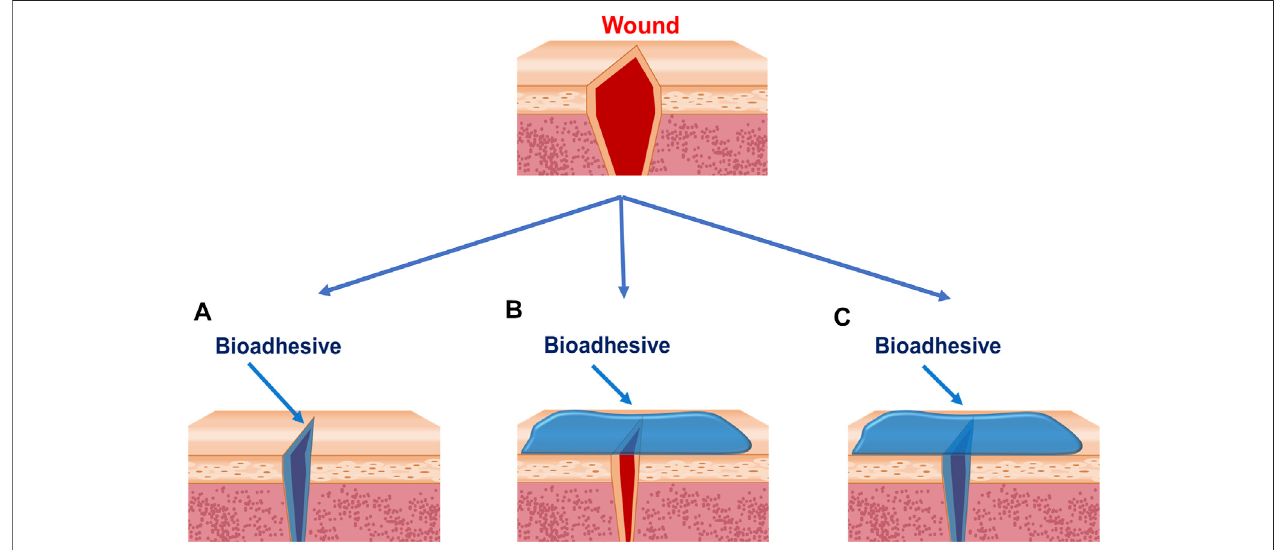
FIGURE 2 | Strategies bioadhesives used to close wounds. (A) Bioadhesives are applied between wound edges. (B) Bioadhesives are applied outside of the wounds. (C) Bioadhesives are applied between and outside the wounds.